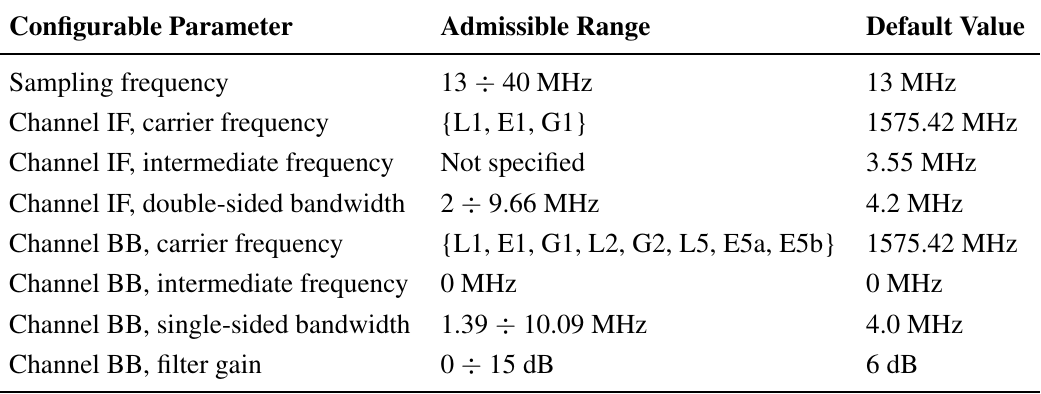
Table 2. Configuration options for the RF front-ends. Channel IF and Channel BB are the two RF chains of each front-end. The rightmost column contains default values used during the tests. The admissible ranges are derived from the examples presented in the Stereo front-end (FE) user manual and have not been completely tested by the